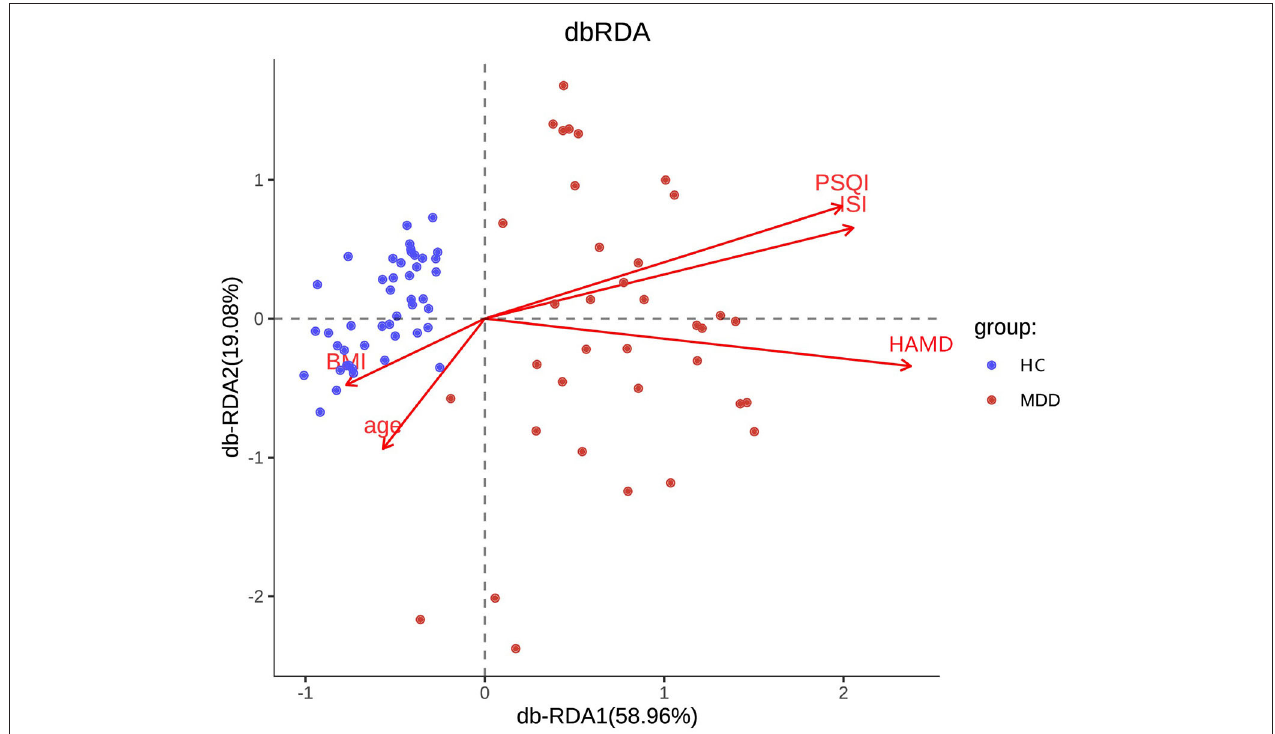
FIGURE 2 | RDA two-way sequence diagram of intestinal bacterial community and its main environmental factors driven by variation.